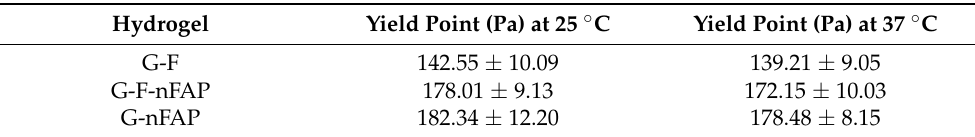
Table 2. The yield points of the G-F, G-F-nFAP, and G-nFAP hydrogels at 25 and 37 ◦ C. The range of the shear rate was 1–300 s − 1 .